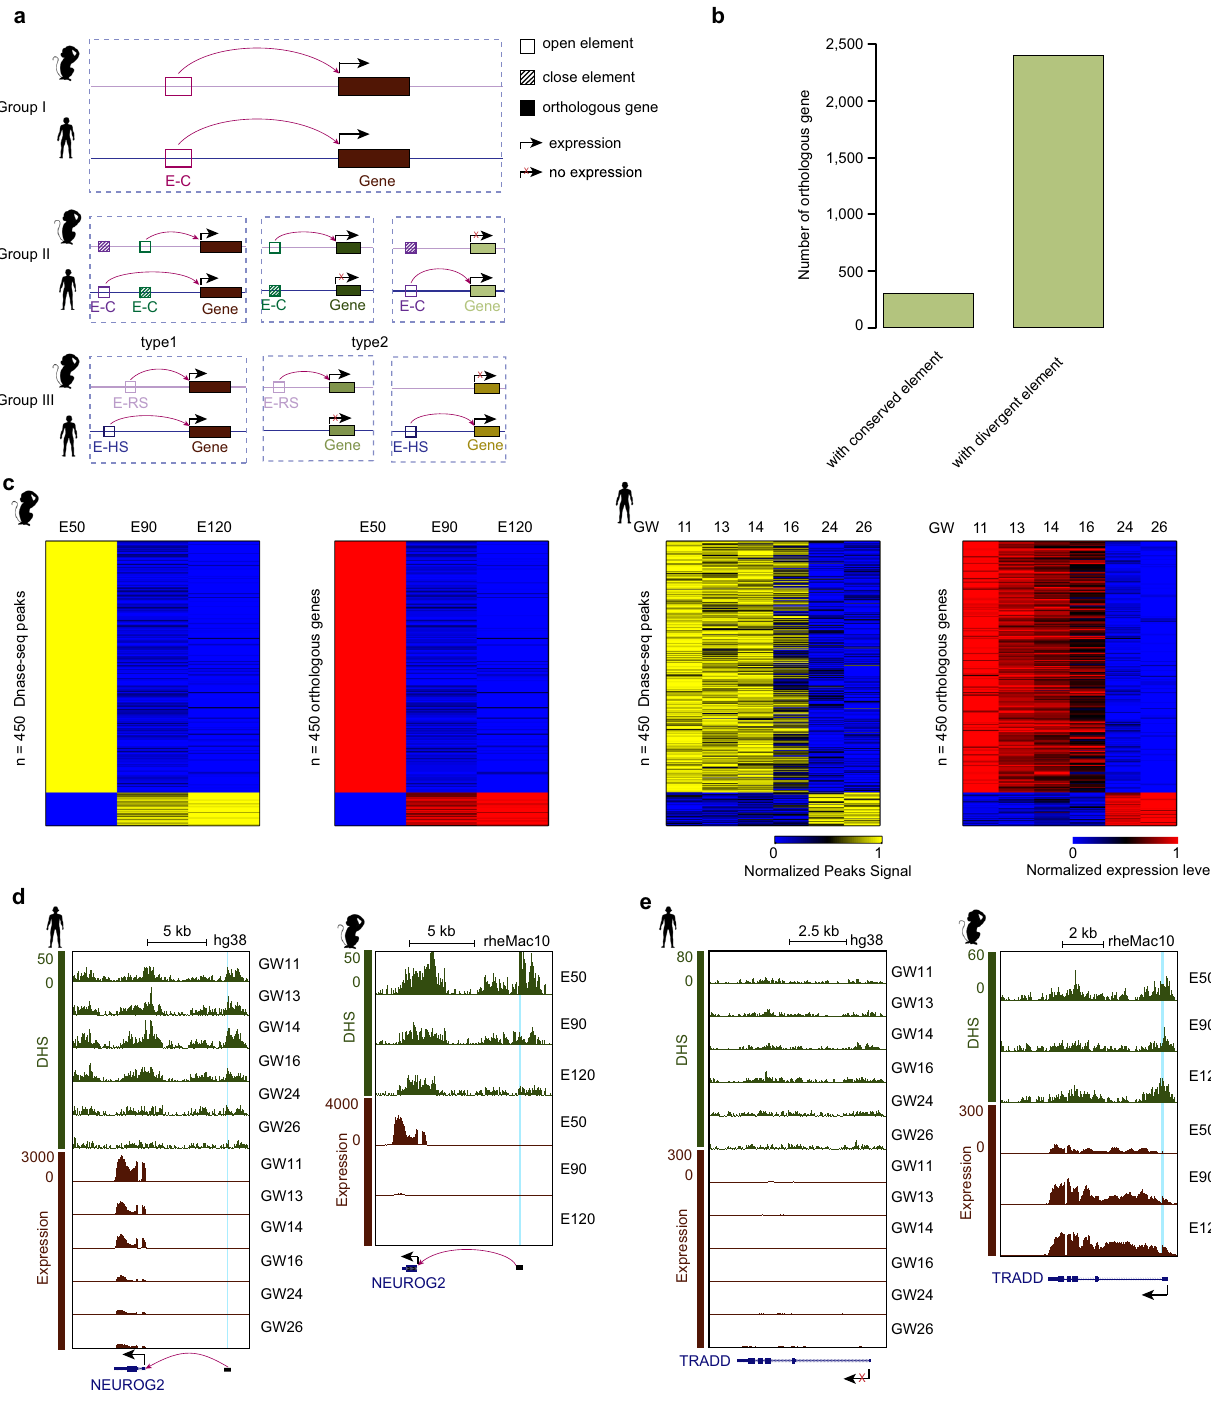
Fig. 2 The conservation and divergence of regulating models for orthologous genes. a Schematics showing three groups of regulatory element-gene pairs between humans and rhesus monkeys. E – C: Element sharing a conserved sequence between human and rhesus, E-HS: element with a human-speci fi c sequence, E-RS: element with a rhesus-speci fi c sequence. b Bar plots show the number of orthologous genes with conserved or divergent elements. c Heatmaps show the orthologous genes with conserved regulatory elements between rhesus monkeys and humans. Each row represents a conserved regulatory element-gene pair. d Genome browser view of expression of the NEUROG2 and the DHS signal of paired regulatory elements in rhesus and human PFC. The light blue shadows mark the paired regulatory elements. The paired regulatory elements of NEUROG2 gene have conserved sequences and chromatin states between humans and rhesus monkeys. The pink arrow indicates the potential regulatory effect of the regulatory element on NEUROG2 . e Genome browser track shows that TRADD is not expressed in the human PFC (left) but is species-speci fi c expressed in the rhesus PFC (right). The light blue shadow marks the position of potential regulatory element of this gene in rhesus monkeys. The sequence of this element is rhesus-speci fi c and cannot be found in